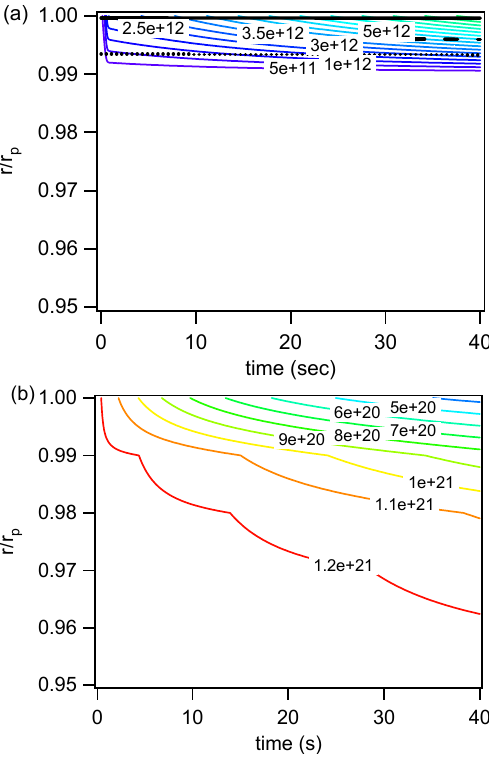
Fig. 9. Temporal evolution of bulk concentration profiles for model base case 3 for (a) ozone and (b) oleic acid (KM-SUB with n = 100). The y-axis indicates the radial distance from the particle cen- ter ( r) normalized by the particle radius, ranging from r/r p = 0 . 95 to the near-surface bulk ( r/r p = 1). The colored lines are isopleths of bulk concentration with labeled in units of cm − 3 (blue=low, red=high). The black solid line represents the reacto-diffusive length for ozone normalized by the particle radius (1 − l rd , X /r p ). The black dotted line represents the 50% isoline for the concentra- tion difference between the particle core and the near-surface bulk, and the black dashed line shows 63% isoline of L ∗ . b